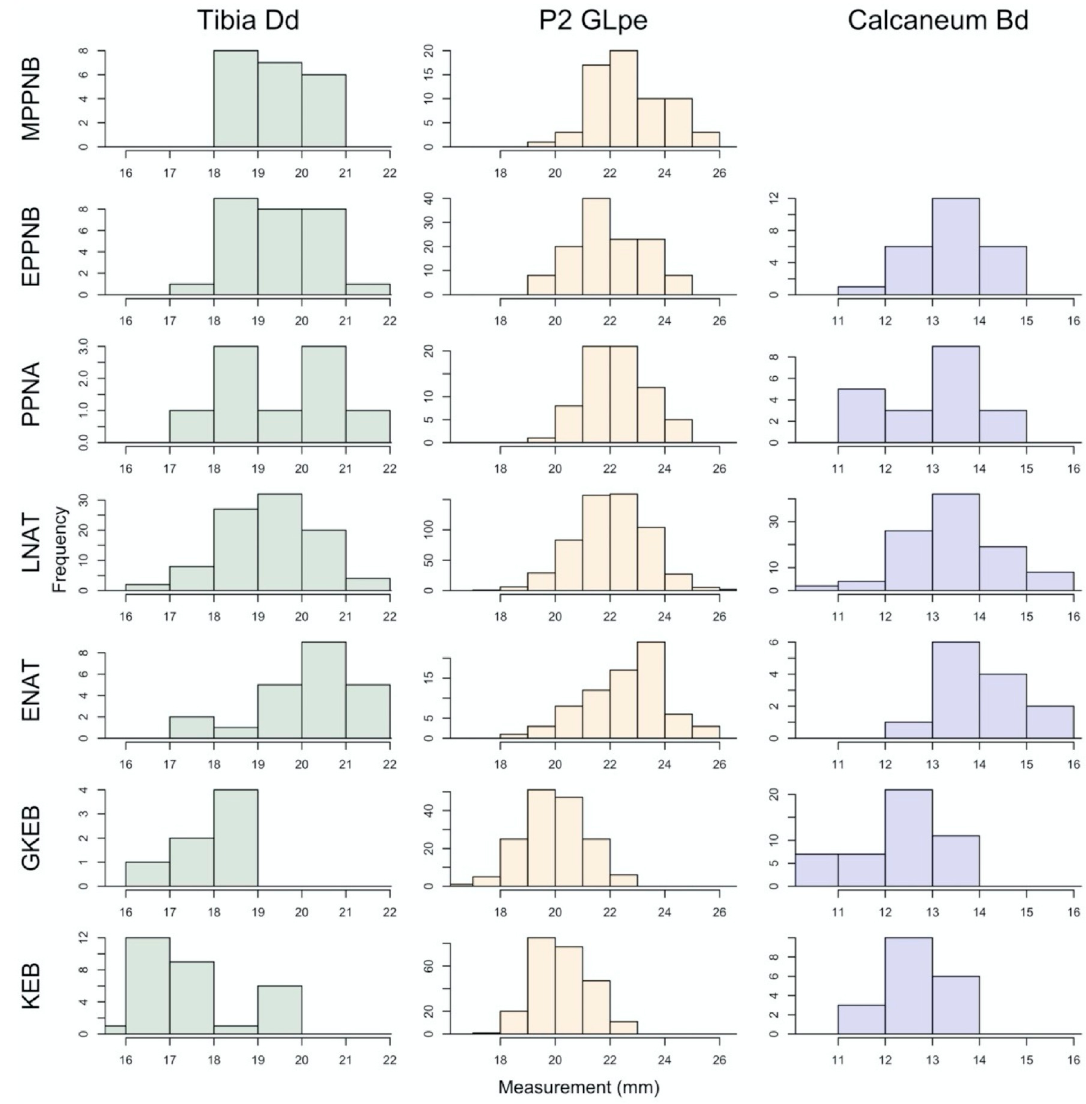
Fig 3. Histograms showing the distribution of the Dd of the tibia, GLpe of the second phalanx and the Bd of the calcaneum in 0.5 mm increments for each of the seven archaeological phases in our study. See Table 1 for sample sizes for each